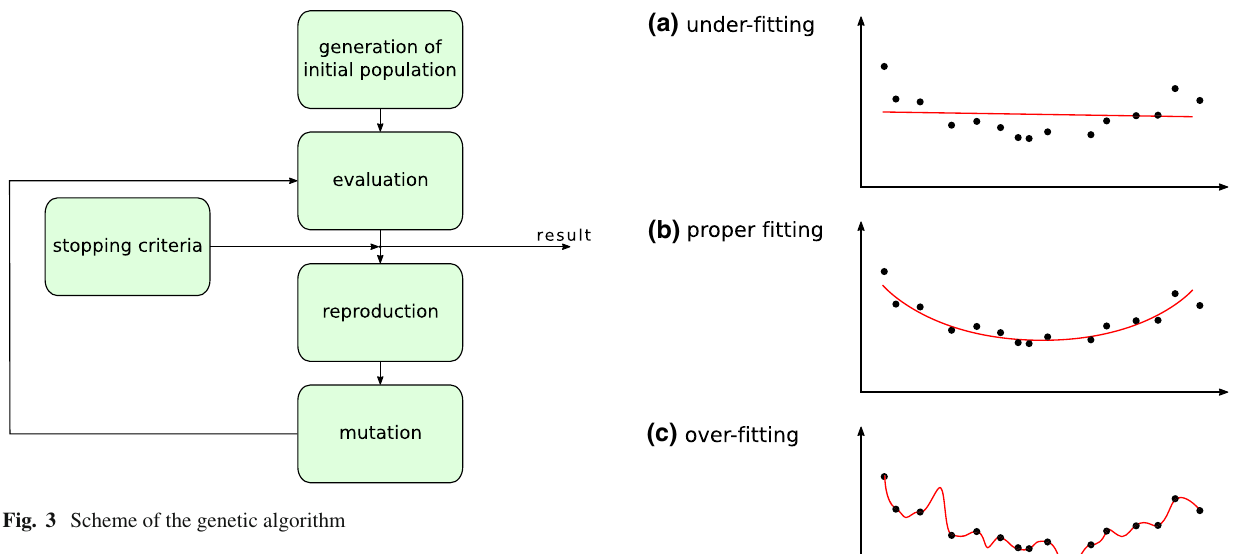
Fig. 4 Illustration of under-fitting, proper fitting and over-fitting. Training data are represented by points, while the effect of a training procedure is represented by red solid curves. The same training data are used in all three